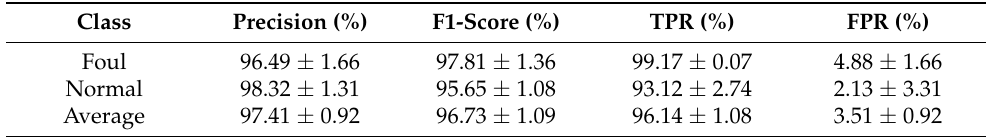
Table 5. Performance metrics of RNN two-class